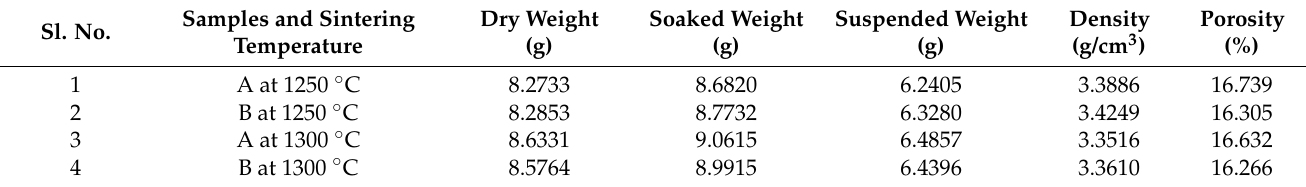
Table 2. Density and porosity measurement of microwave sintered samples.